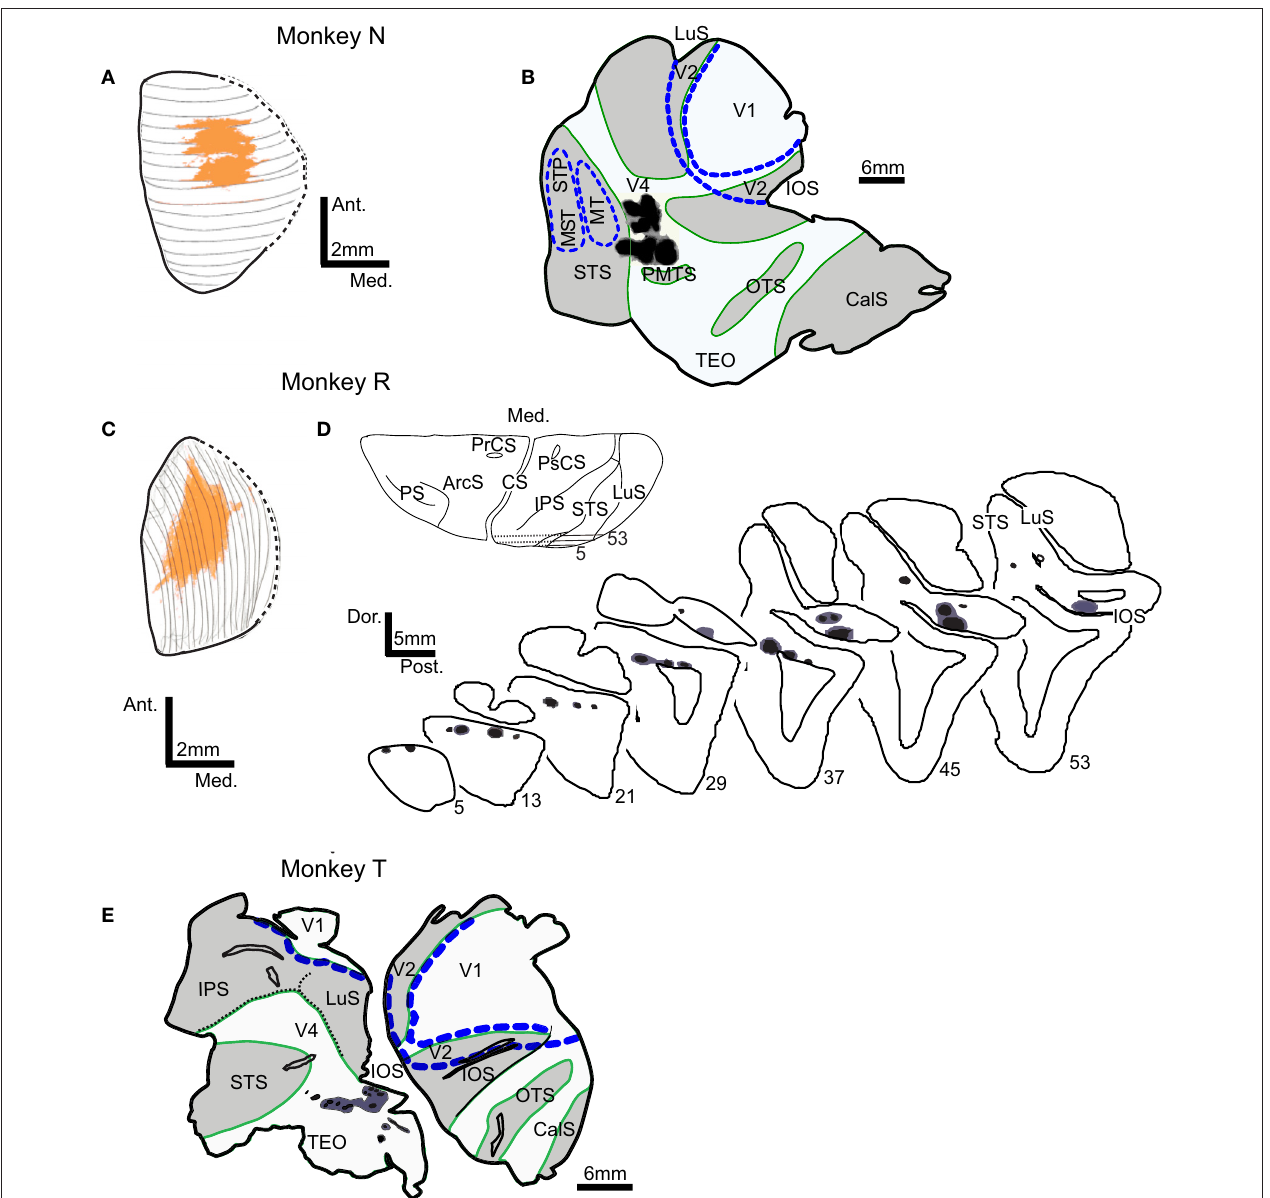
FIGURE 1 | Locations of tracer injection sites in the superior colliculus (SC) and extrastriate visual areas V4 and TEO. Injection sites in monkeys N and R are shown on the dorsal view of SC reconstructed from the series of (A) coronal or (C) sagittal sections. In both monkeys, injections in SC (orange) cover the central part of SC. Injections in visual cortex (injection zone – black, diffusion zone – dark gray) are shown on the surface view of fl attened cortex (B,E) and on the series of sagittal sections (D) . Borders of areas V1, V2, MT, and MST/STP (blue dashed lines) were determined from adjacent sections stained for cytochrome oxidase and myelinated fi bers. In fl attened cortex opened sulci are